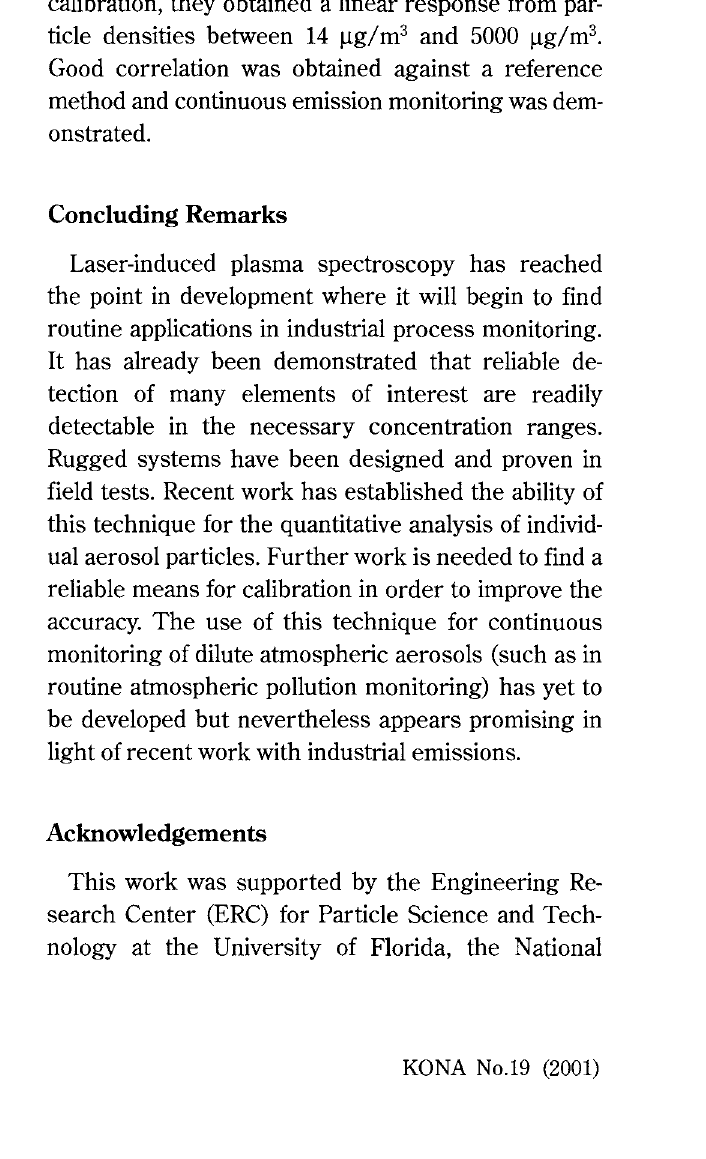
system (Nd:YAG, 1064 nm, 200 rn]/pulse)